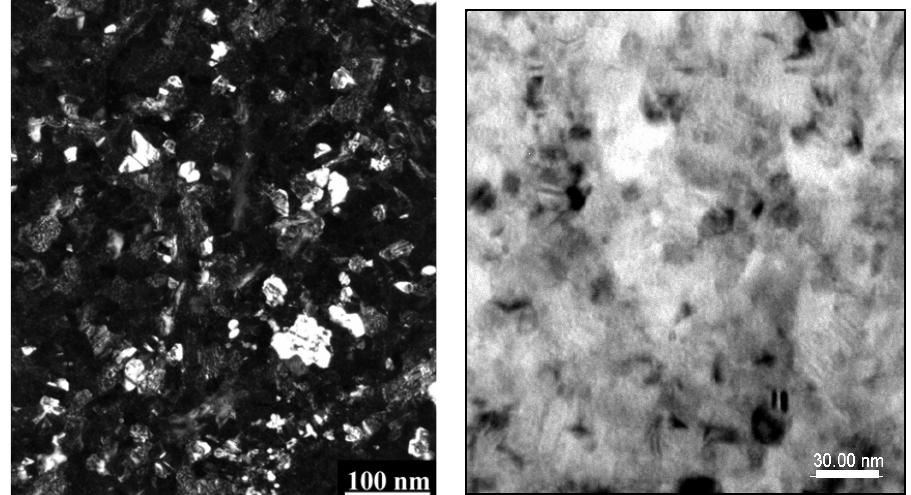
Figure 3. Transmission electron micrographs of two typical, granular area of the Fe-Pt-Mo-B annealed sample. Left hand image is the dark field mode TEM while the right hand image is the bright field mode TEM.